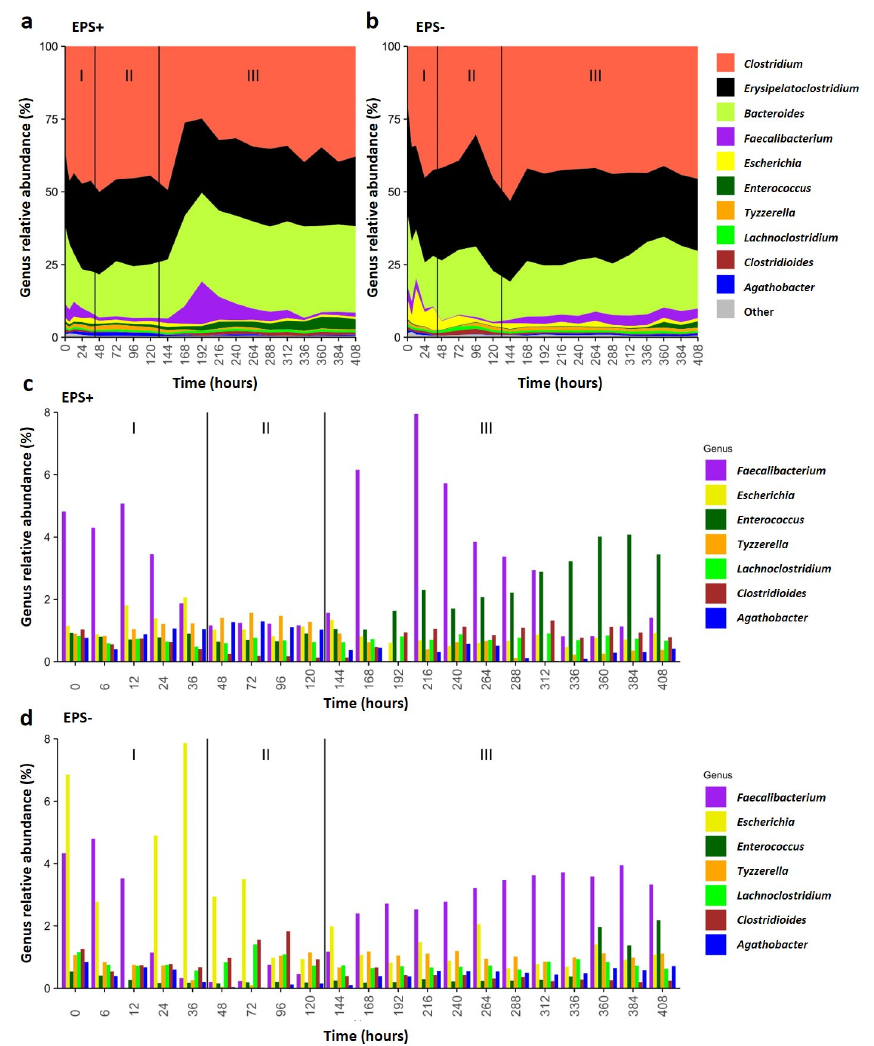
Figure 3. Microbiota profiling in EPS+ and EPS − vessels. Area plot of proportional read counts and total genus abundance of 16S rRNA gene analyses of ( a ) EPS+ and ( b ) EPS − model colon vessels. ( c ) EPS+ and ( d ) EPS − vessel changes (by phase) in the abundant genera.